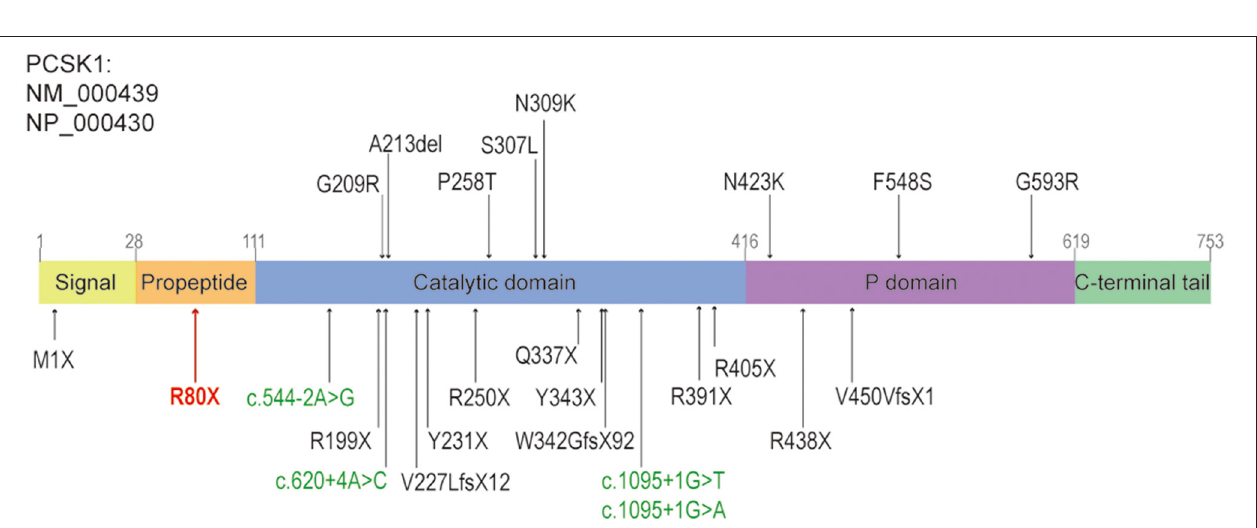
FIGURE 3 | The structure of PCSK1, and the reported variants caused diarrhea, including this study. The missense variants and non-frameshift variants were shown above the panel, the nonsense, frameshift variants or splice sites were shown below the panel. The splice sites were shown in green, the nonsense variant identified in this study was shown in red. Revised from reference (Martin et al.,